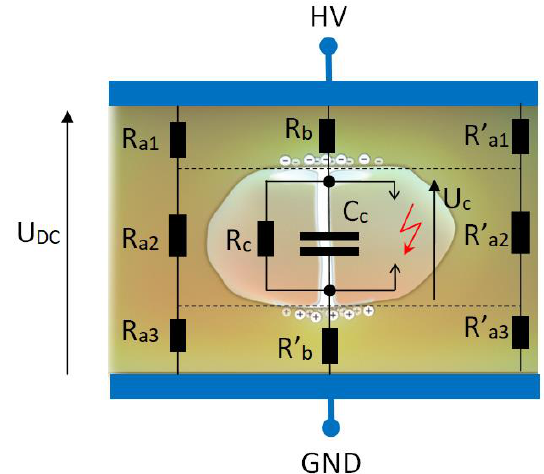
Figure 1. Equivalent circuit for partial discharge (PD) modeling at direct current (DC).